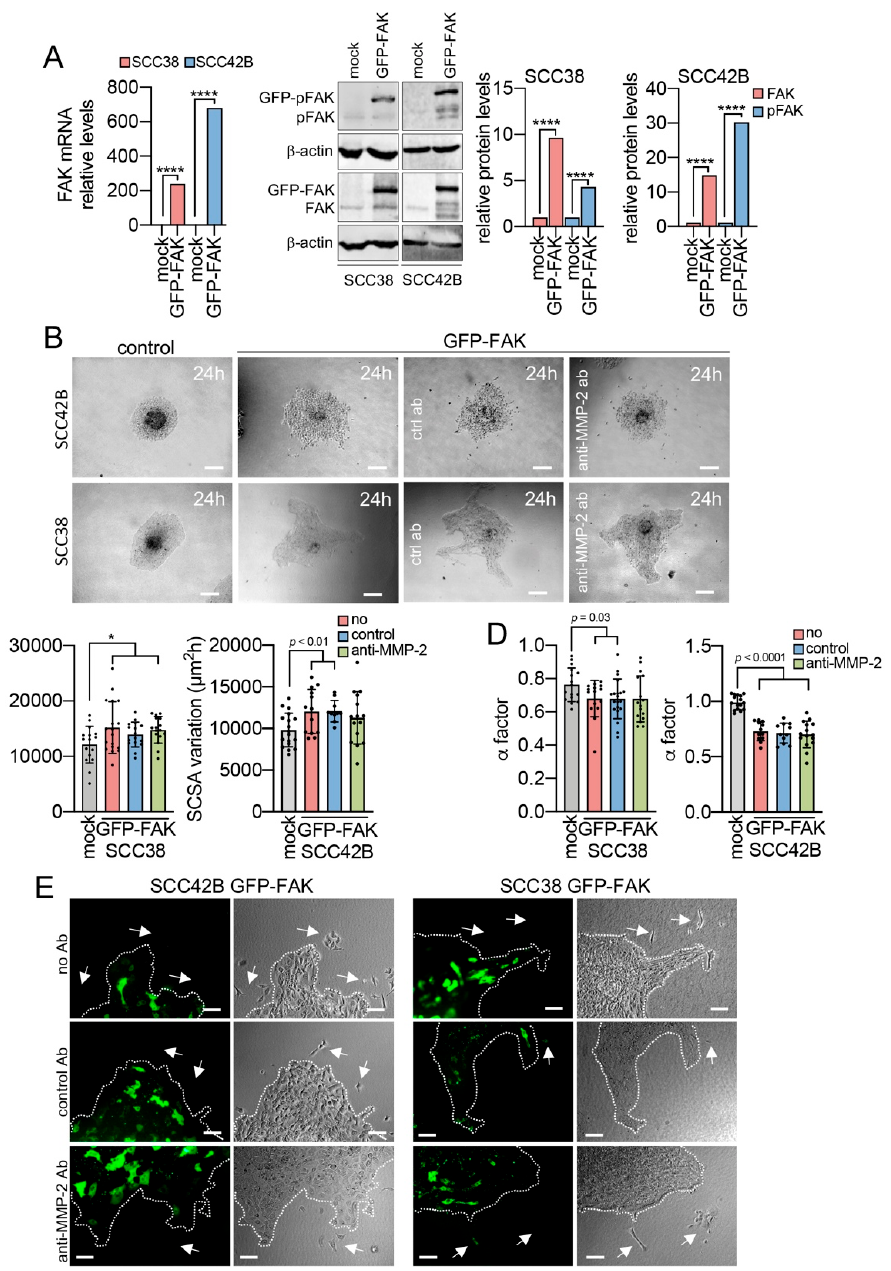
Figure 6. FAK over-expression not only induces collective cell invasion but favors the emergency of cells that detach from the spheroids. ( A ) Representative data showing the e ffi ciency of GFP-FAK expression in transiently transfected cells. Representative immunoblot analysis of FAK and pFAK in mock- and GFP-FAK-transfected cells is shown in the middle. The membranes were stripped and reprobed with anti- β -actin antibody to assure even loading of proteins in each lane. The ratio FAK or pFAK / β -actin was estimated by densitometry. Graphics show relative quantification of FAK mRNA, and FAK and pFAK proteins in the indicated cells. ( B ) Representative images of spheroids assembled with the indicated cells after 24 h of migration in the absence of any antibody or in the presence of control or anti-MMP-2 antibody. ( C ) Variations over time of the SCSA of the indicated spheroids. ( D ) Variations of the α factor of the indicated spheroids after 24 h of migration. ( E ) Representative bright field and fluorescence images of the indicated spheroids after 24 h of incubation in the presence or absence of the indicated antibodies. White dashed lines indicate the periphery of the spheroids. White arrows point to cells that escaped from the spheroids and migrated as single cells, most of which were GFP-negative. Scale bars, 100 µ m. * indicates p < 0.01, **** indicates p <